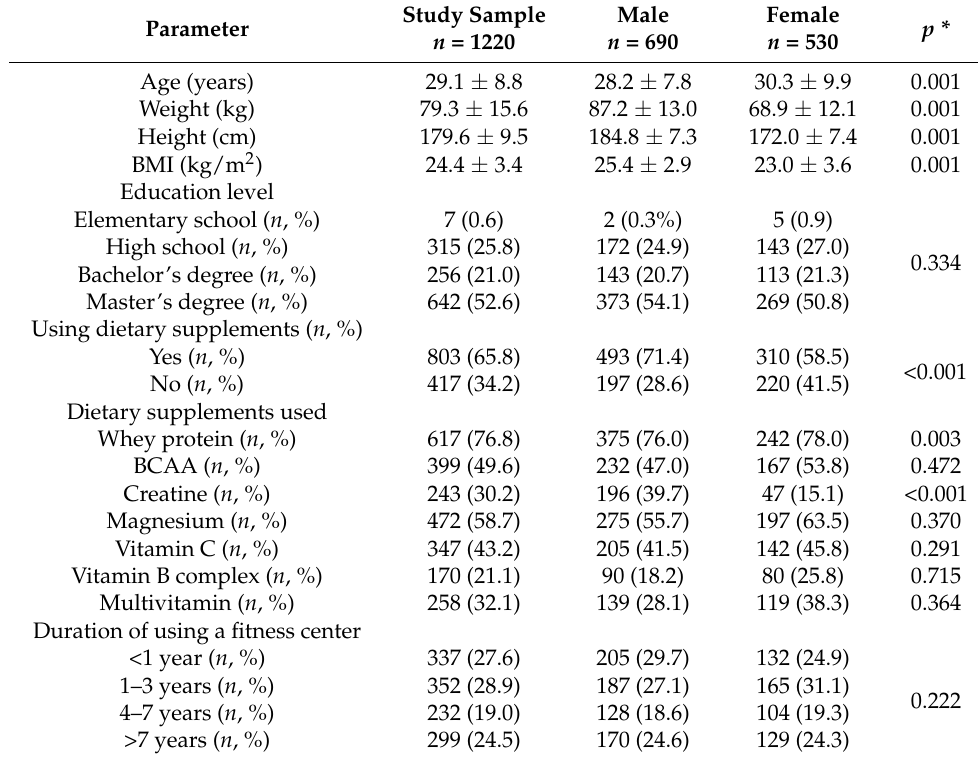
Table 1. Baseline characteristics of the study sample and differences regarding